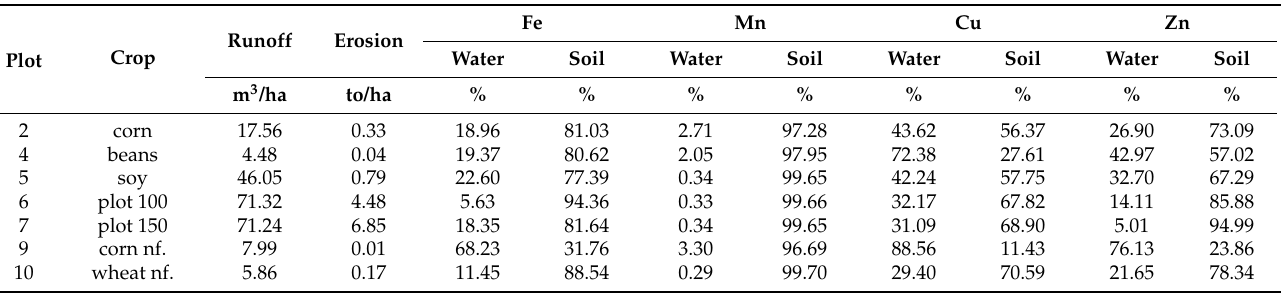
Table 10. Percentage repartition of the losses of Fe, Mn, Cu, and Zn through water and soil, SCDCES— MM